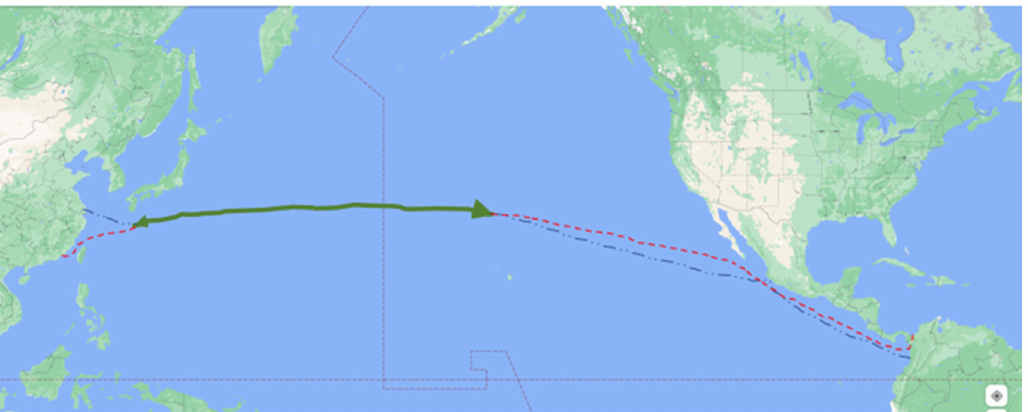
Figure 1. Transoceanic routes measured the FO consumption and carbon dioxide emissions in the solid green line